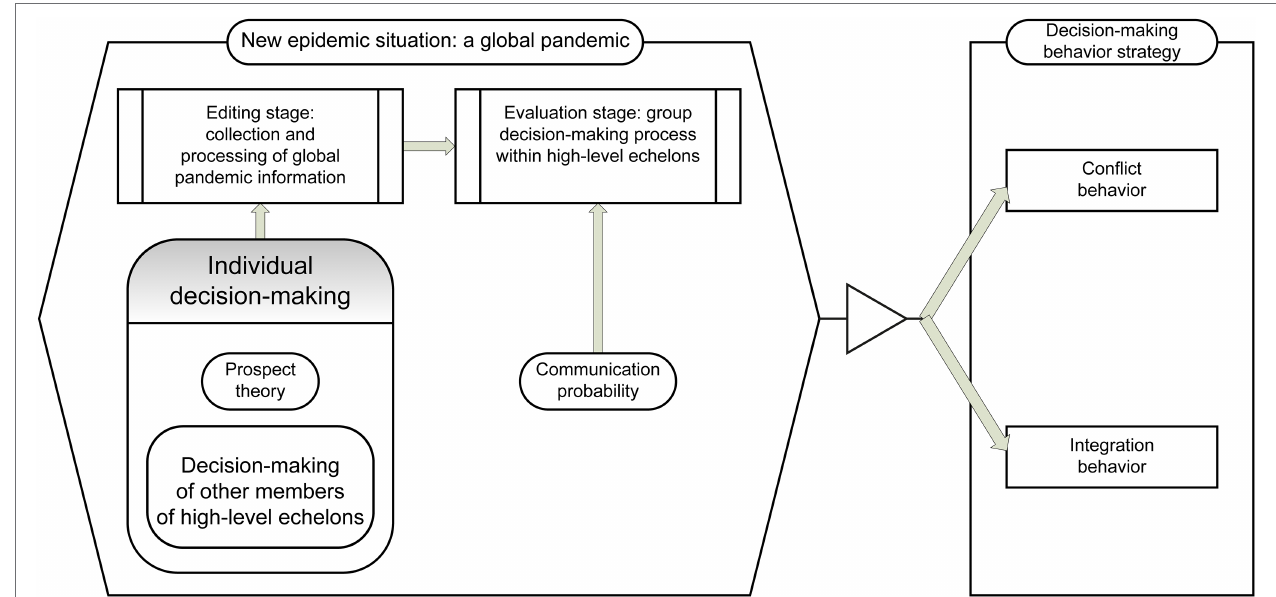
FIGURE 2 | Selection model of the upper echelon conflict and integration behaviors based on prospect